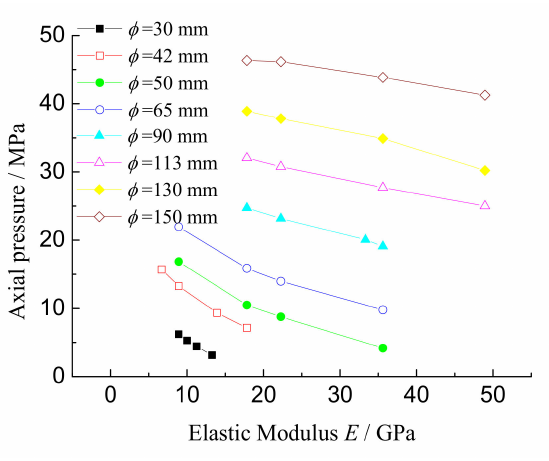
Figure 6. Relationship between simulated axial expansive pressure and elastic